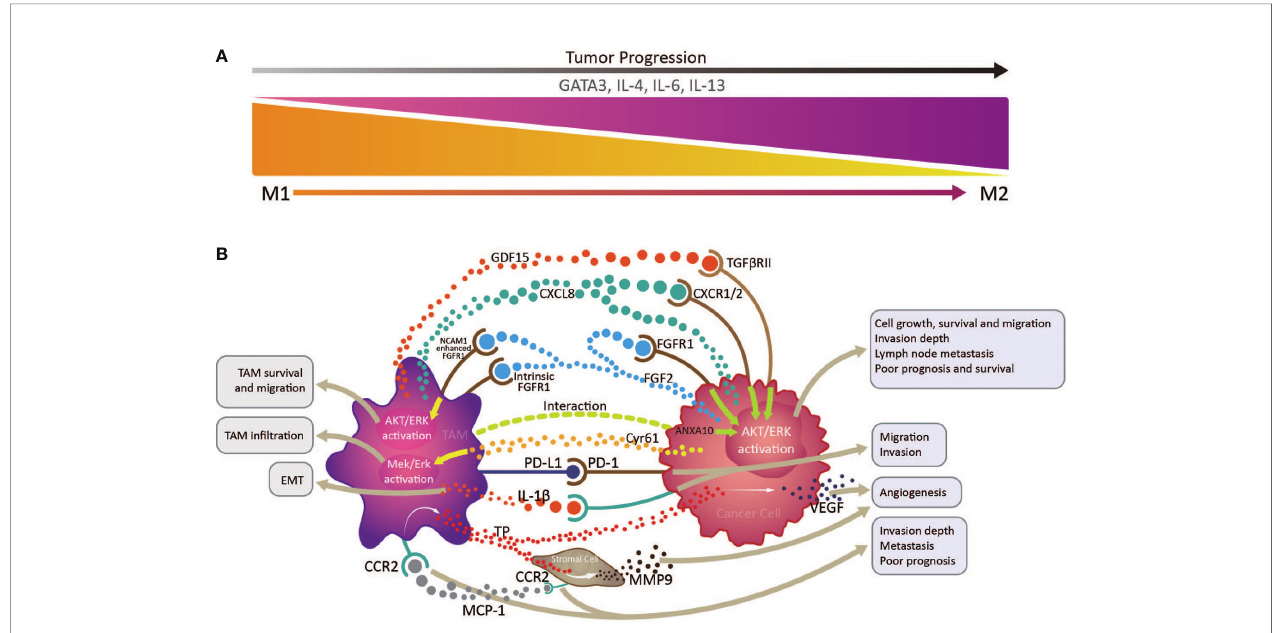
FIGURE 2 | Interactions between tumor in fi ltrating macrophages, cancer cells, and stromal cells via multiple immune factors in the esophageal cancer tumor microenvironment. (A) tumor in fi ltrating macrophages (TAMs) transform from an anti-tumor M1 phenotype to a pro-tumor M2 phenotype with tumor progression, under the in fl uence of the transcription factor, GATA3, and cytokines, including IL-4, IL-6, and IL-13. (B) By producing various immune factors, or interacting with cancer cells and stromal cells to promote their release of associated components, TAMs are closely correlated with epithelial to mesenchymal transition, angiogenesis, cancer cell survival and migration, invasion depth, and lymph node metastasis, and generally predict poor prognosis and survival in patients with esophageal